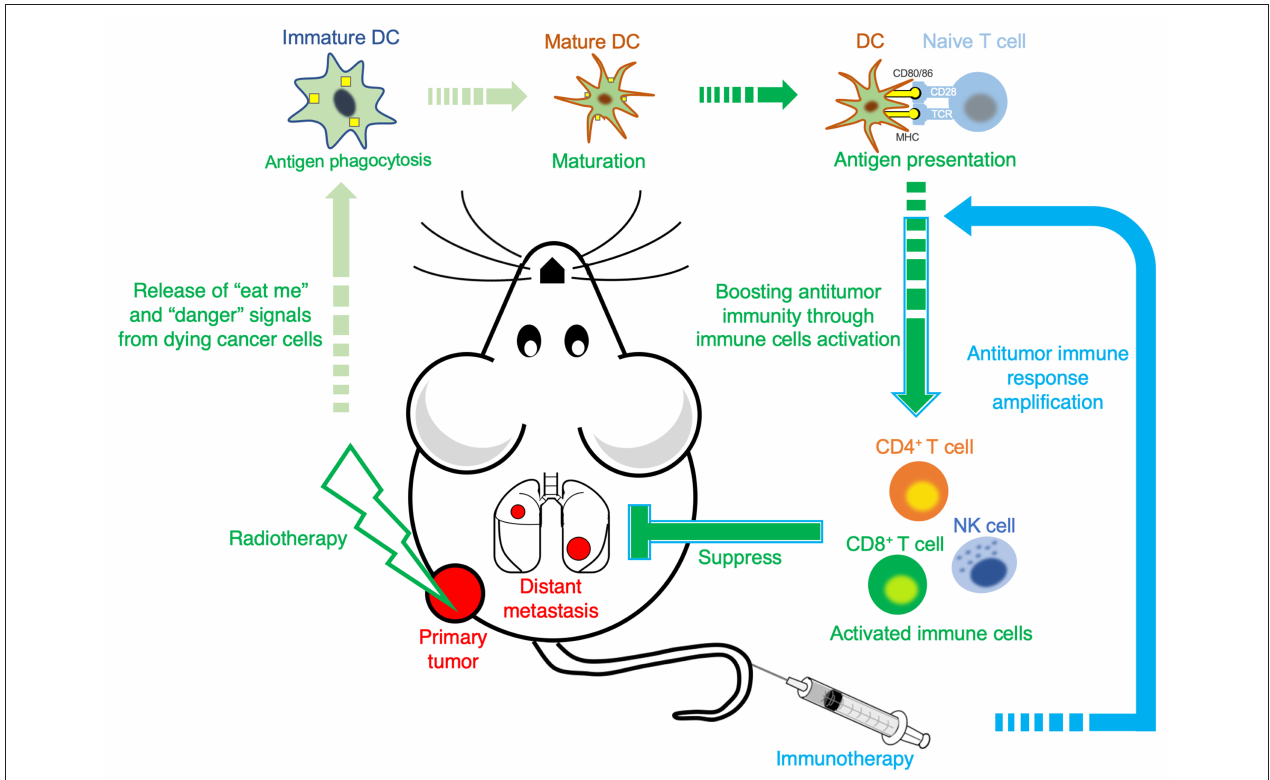
FIGURE 1 | A possible mechanism of antitumor immunity by radiotherapy combined with immunotherapy. Following local tumor irradiation, “eat me” signal (cell surface calreticulin) and “danger” signals (such as high mobility group box 1 and adenosine triphosphate) are released from the dying cells and introduced directly by the dendritic cells (DCs). The DCs gradually mature after phagocytizing antigens, and then activate and direct them to present the tumor antigens to T cells, which are active and direct immune cells, to locate out and suppress both local tumor and distant metastasis. Immunotherapy further amplifies this antitumor immune